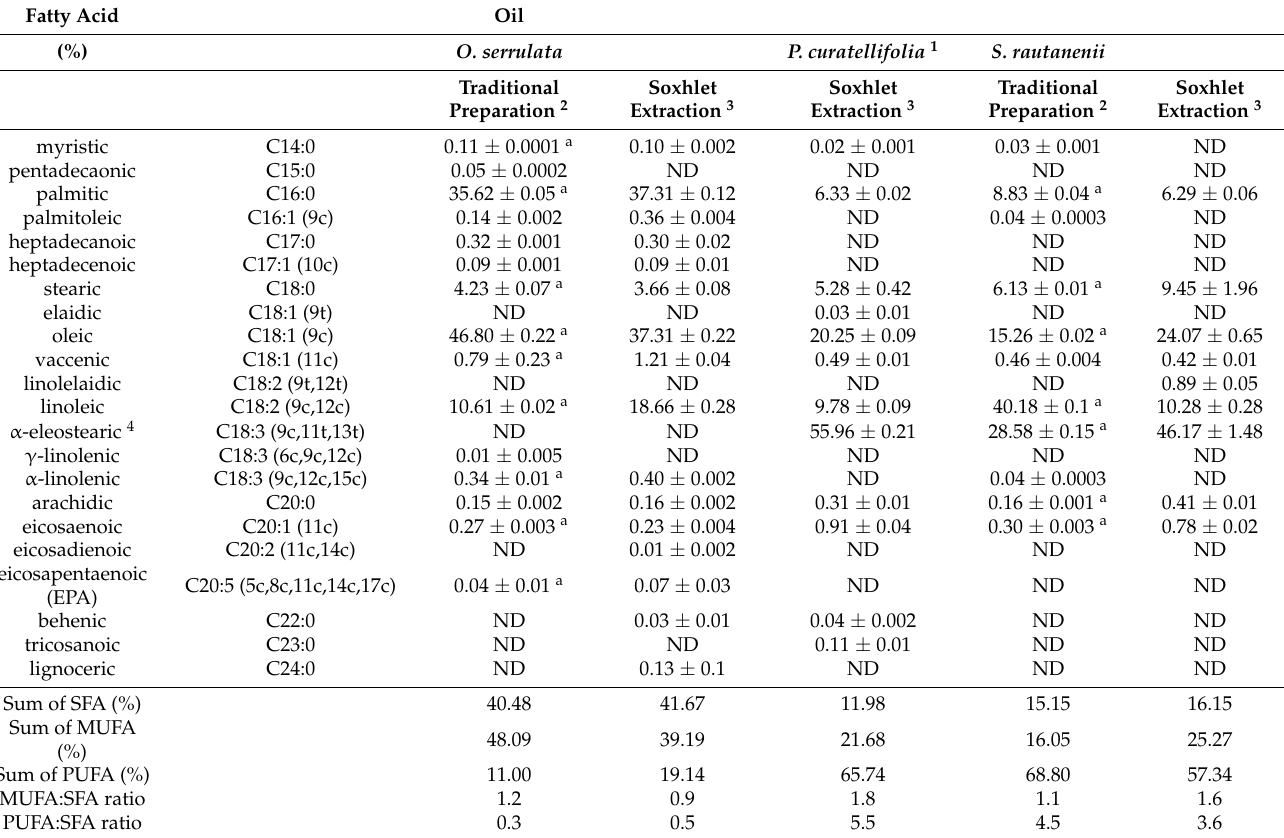
Table 2. Fatty acid composition of the oils.